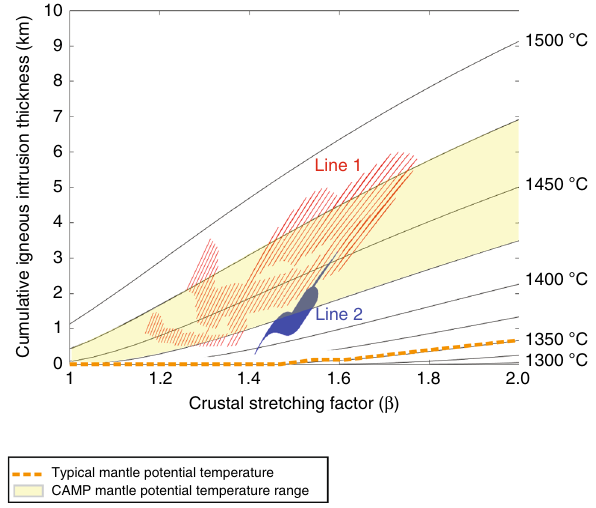
Fig. 3 Decompression melting models compared to seismic constraints. Predicted magmatic intrusion thickness assuming uniform lithospheric stretching at a range of mantle potential temperatures (black lines and text). Red and blue lines show the estimated range of magmatic intrusion thicknesses from SUGAR velocity models (Fig. 2). The orange line shows expected intrusion thickness for a baseline scenario with a normal mantle potential temperature of 1350 °C. The yellow shaded area shows range of mantle potential temperatures for CAMP from geochemical constraints 11,12